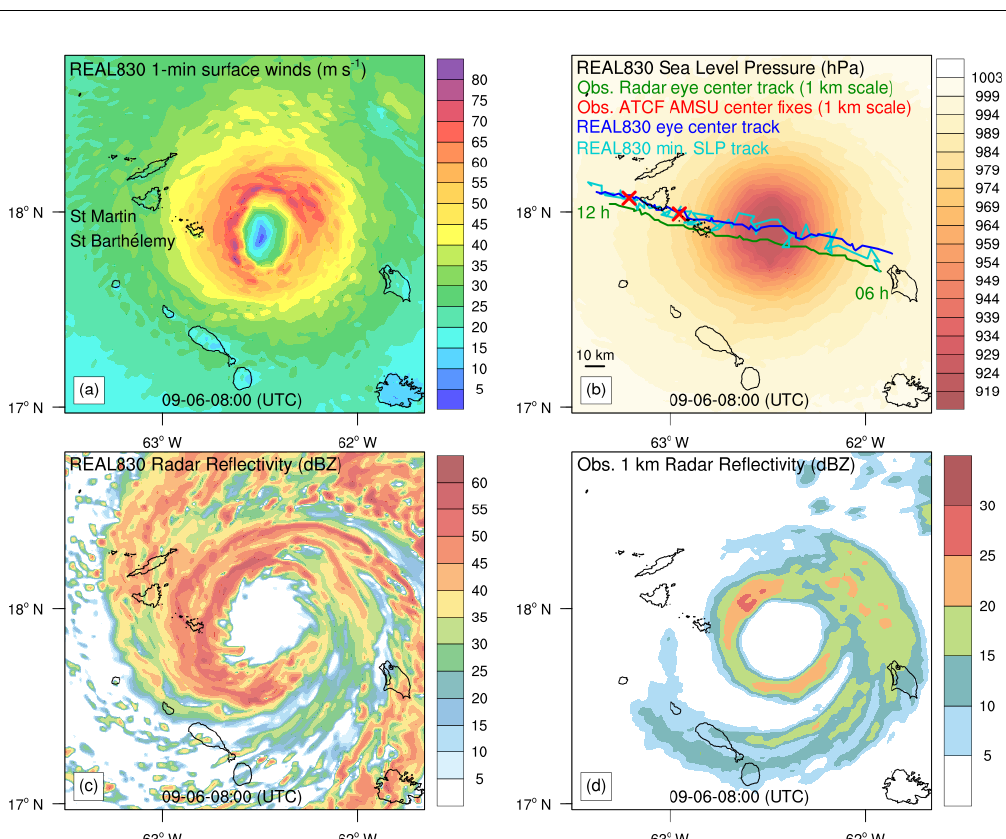
Figure 3. Simulated Irma eye at 830m scale and at 08:00UTC (REAL830). (a) Sustained surface winds (ms − 1 ). (b) Sea level pressure ( hPa ) with simulated tracks and observed radar eye center track. The time interval for all tracks is 5min. (c) Simulated radar reflectivity (dBZ). (d) Observed radar reflectivity